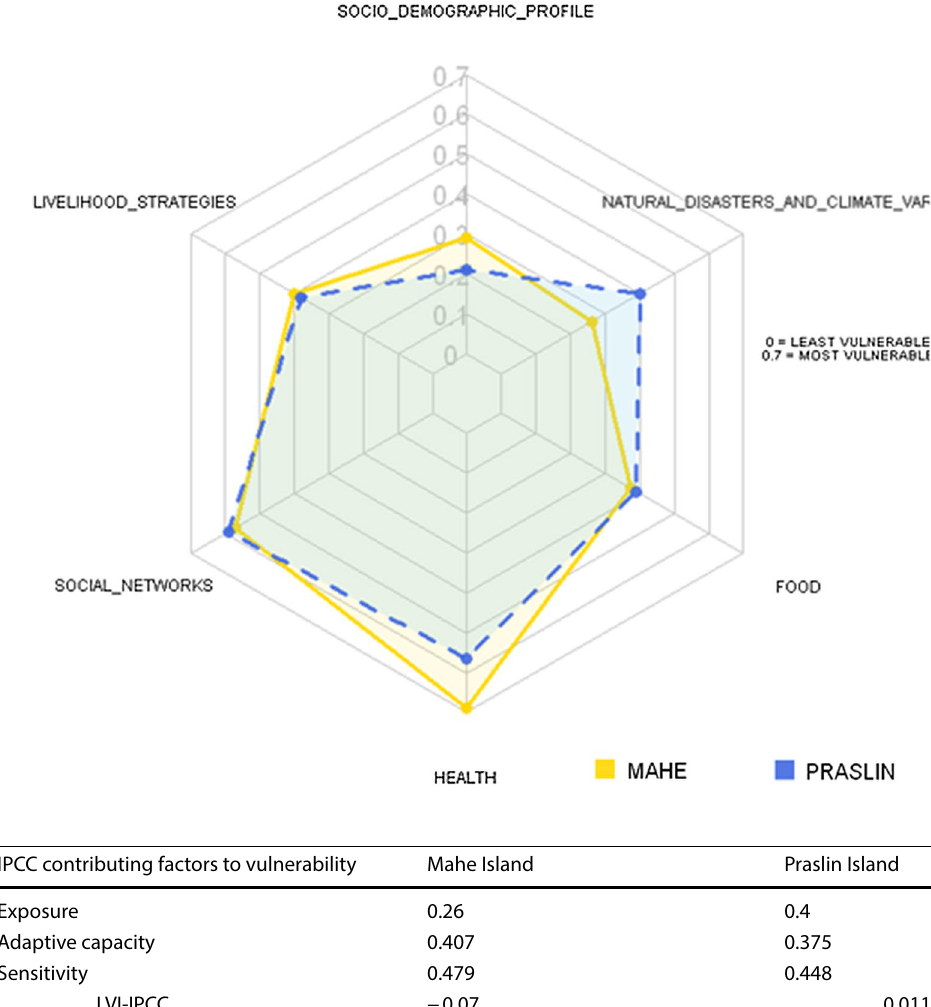
Fig. 2 Vulnerability radar chart of the major compo- nents of the Livelihood Vul- nerability Index (LVI) for Mahe and Praslin Island